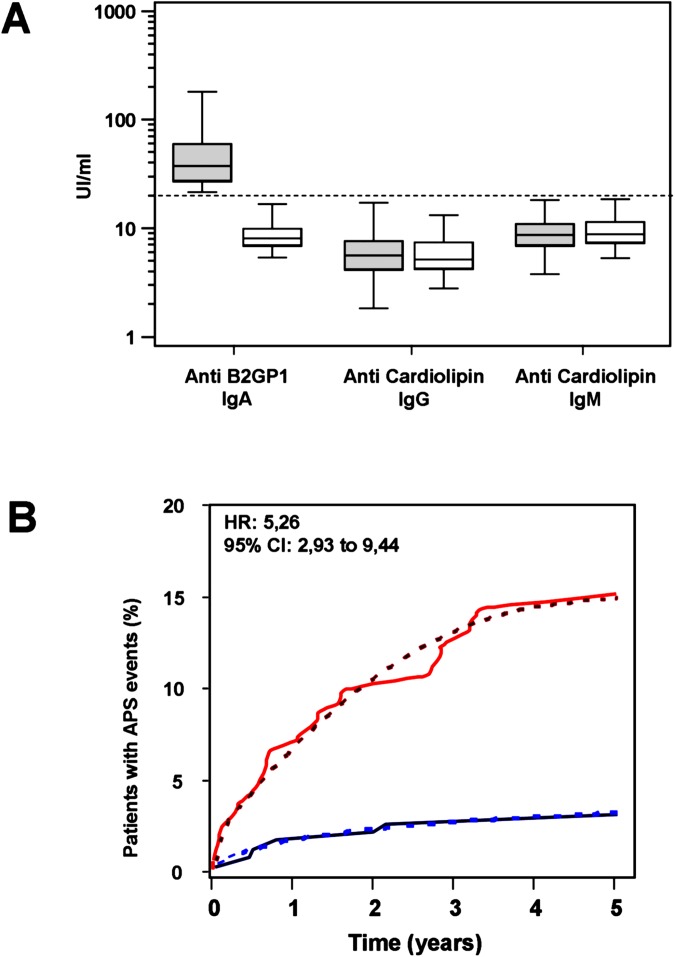
A. Levels of IgA anti B2GP1 and IgG and IgM anticardiolipin antibodies in Group-1 (grey) and in Group-2 (white). Dotted line corresponds to the cut-off. B. Accumulation of events as a function of time (p<0.001) in group 1 (red) and Group-2 (blue). Dotted lines represent trends.